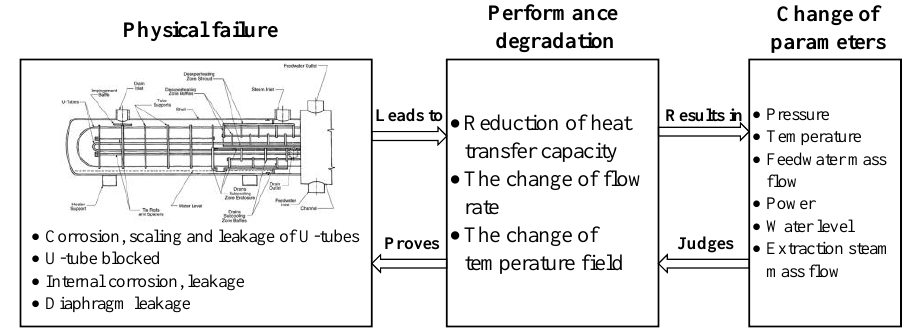
Figure 4. Schematic diagram of fault influence mechanism.